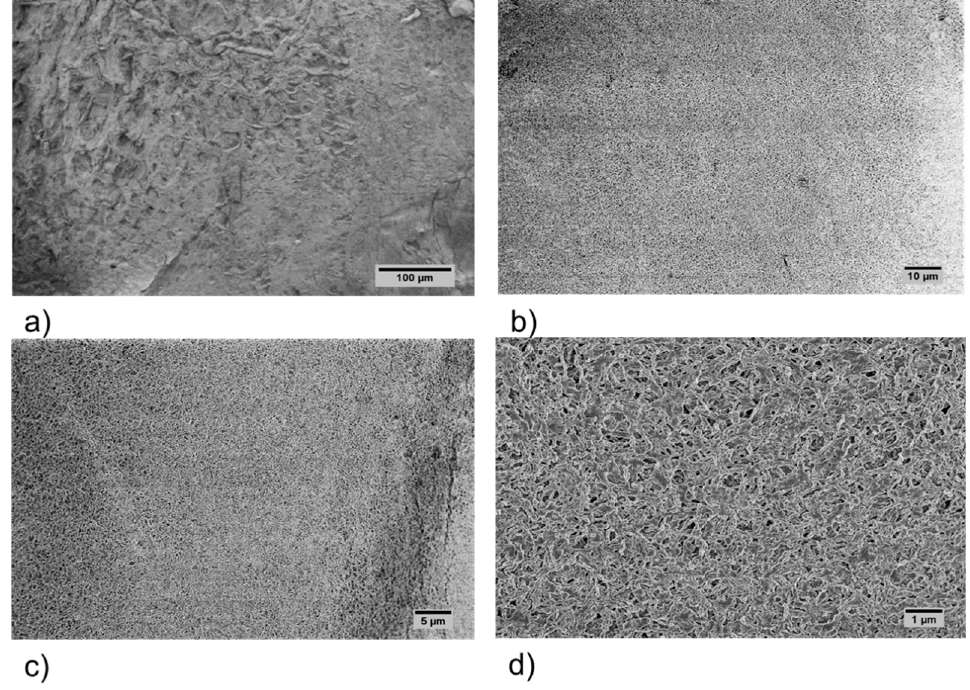
Figure 3. SEM micrographs of M1 acemannan aerogel at 200 × ( a ), 1000 × ( b ), 2000 × ( c ) and 10,000 × ( d ) magnification.